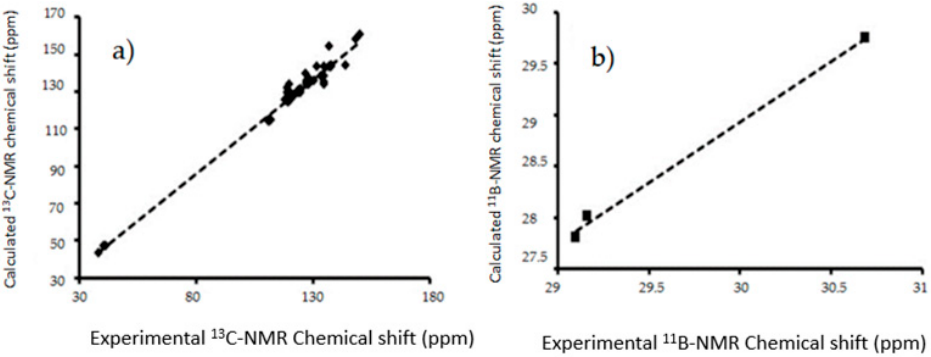
Figure 9. The linear regressions between experimental and B3LYP/6-311++G(d,p) calculated ( a ) 13 C-NMR chemical shifts for in gas phase ( b ) 11 B-NMR chemical shifts in gas phase I – III .